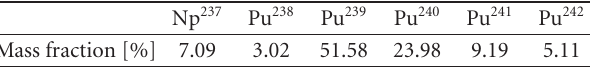
Table 3: PBMR initial HM composition (coming from typical LWR SNF; please see Table 1).